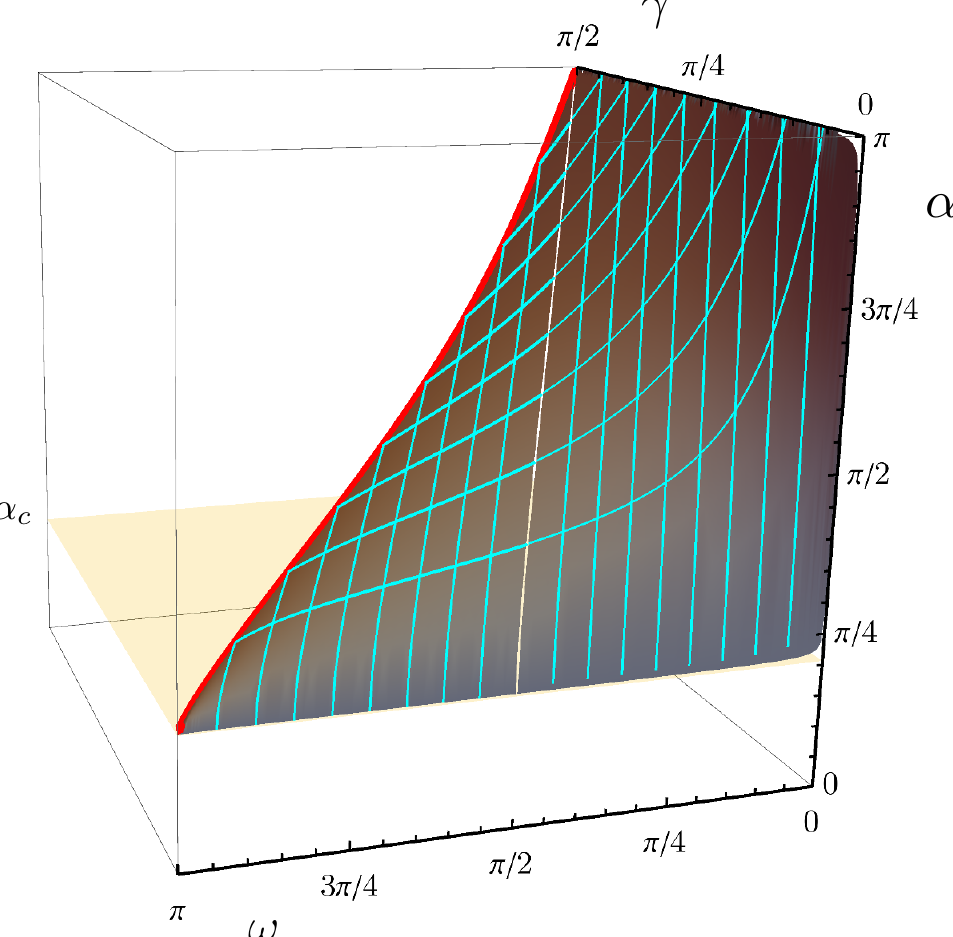
Figure 20 . In(cid:12)nite wedge with only the tip on the boundary: the surface described by the critical con(cid:12)gurations, de(cid:12)ned by (7.5) in the parameters space given by the angles ! , (cid:13) and (cid:11) . The yellow plane is (cid:11) = (cid:11) c . The red curve corresponds to the symmetric con(cid:12)gurations having ~ (cid:13) = (cid:13) (see (cid:12)gure